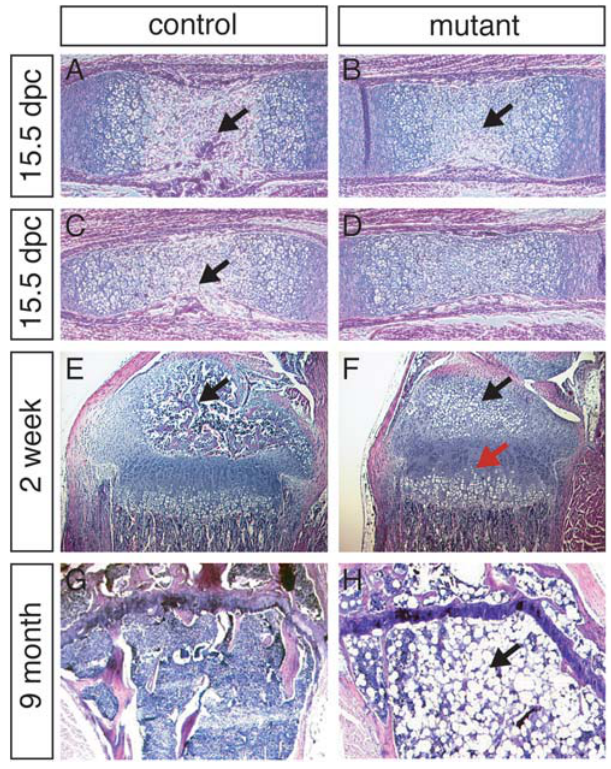
Figure 5. Histological analyses of long bones. A, C, E, G are H & E stained histological sections of R26 floxneoWnt4 heterozygous controls; and B, D, F, H are R26 floxneoWnt4 ; Col2a1-Cre mutants. A, B, 15.5 dpc tibiae. C, D, 15.5 dpc femurs. The formation of the primary ossification center (arrows) was delayed in both tibiae and femurs of the mutant in comparison to controls. E, F, 2-week-old tibiae, showing development of the secondary ossification center (black arrow) in the control but only chondrocyte hypertrophy (black arrow) in the mutant that also had a disorganized growth plate (red arrow). G, H, 9-month-old mutant tibia with little bone marrow (G) filled with adipocytes (H,